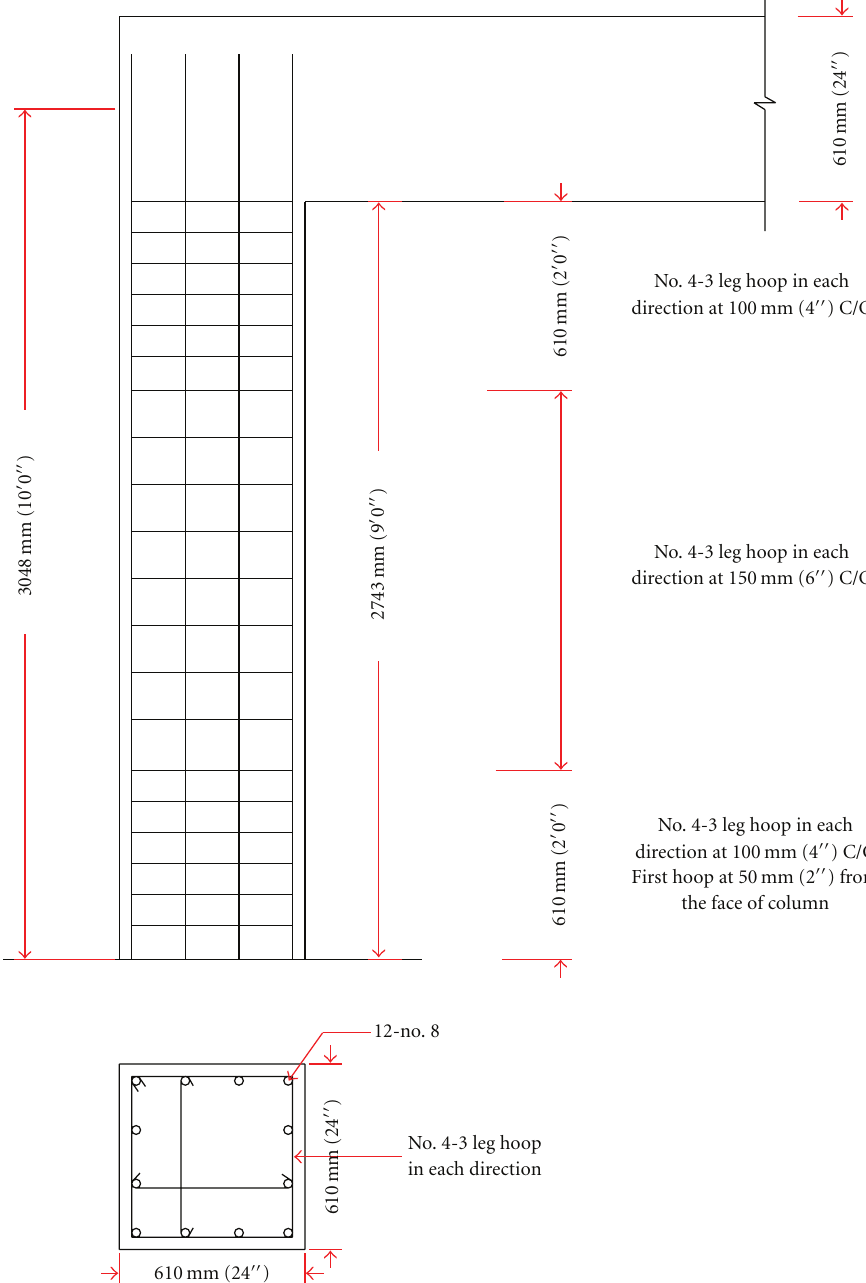
Figure 4: Reinforcement detail of the prototype